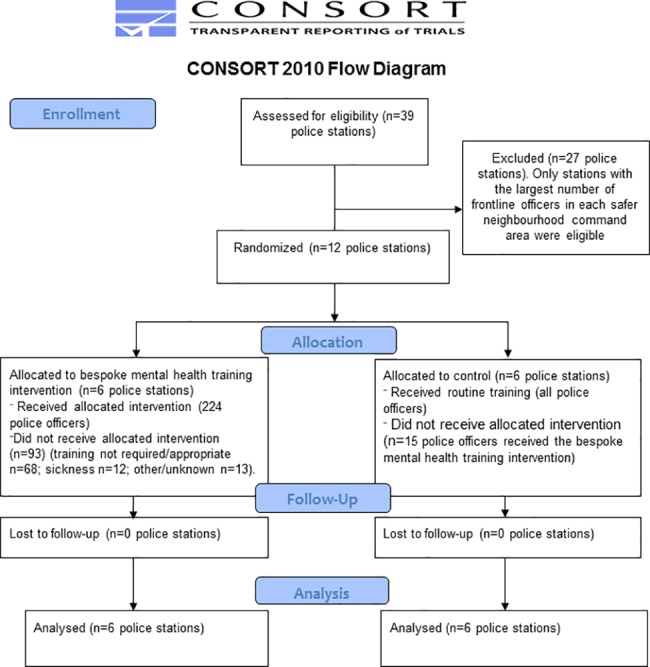
CONSORT flow diagram.